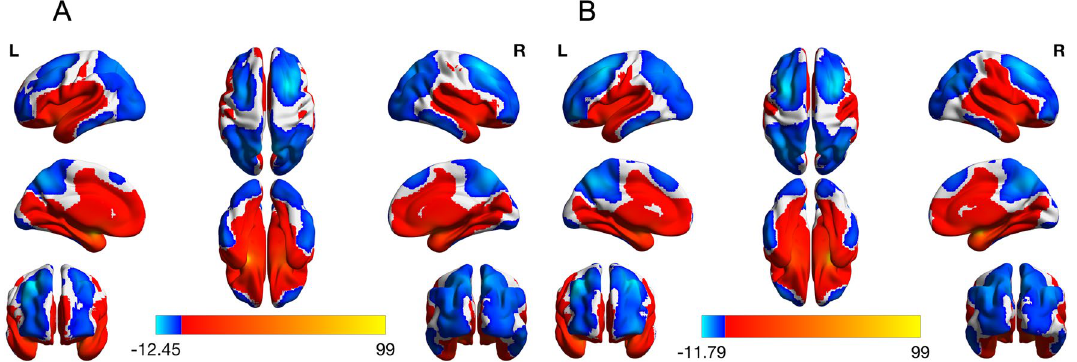
Figure 1. Left and right amygdala functional connectivity in the whole sample. Left and right amygdala functional connectivity with the rest of the brain was determined using a one sample t-test (p < 0.05, corrected). Both the left and right amygdala showed positive connectivity with the medial frontal cortex, middle and anterior cingulate as well as the superior temporal cortex and sensorimotor areas. Positive connectivity to the basal ganglia, the hippocampus, the fusiform and the insula was also observed. Areas with negative correlation to the left and right amygdala included the lateral frontal cortex, parietal lobe and occipital cortex in addition to the precuneus, posterior cingulate and a region of the inferior temporal cortex (left amygdala connectivity is pictured in ( A ), while right amygdala connectivity is pictured in ( B